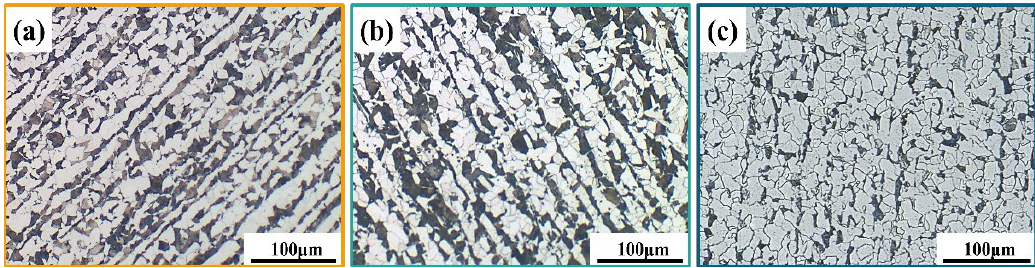
Figure 1. Microstructures of the tested steel rebars: ( a ) BM, ( b ) Cr, and ( c ) RE.